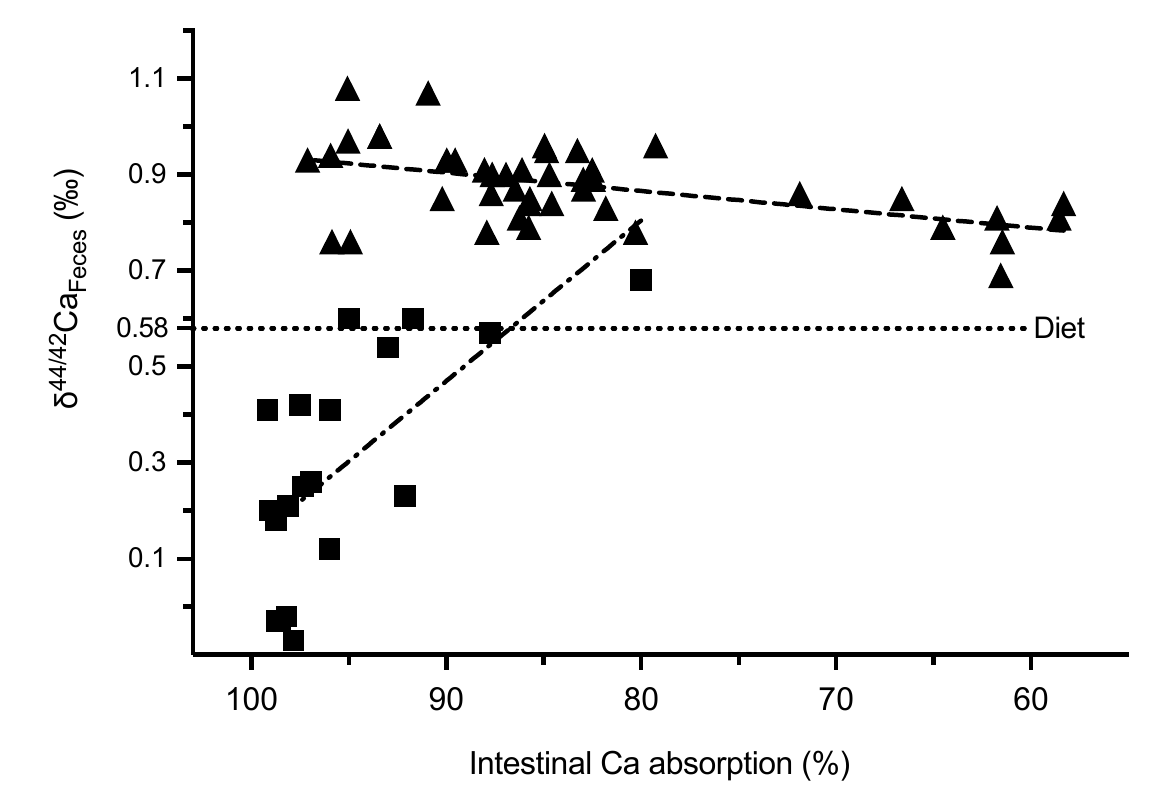
Figure 3. Relative intestinal Ca absorption versus δ 44/42 Ca Feces. The amount of Ca absorbed relative to the dietary Ca intake is given on the x-axis and δ 44/42CaFeces on the y-axis in animals on standard- Ca-diet (triangles; baseline values, group 2 weeks one to six and group 3 weeks one to two) and low-Ca-diet (squares; group 3 week three to six). The dotted line marks the isotope composition of the diet. In all animals on the standard-diet, increasing intestinal Ca absorption was accompanied by an increase in δ 44/42 Ca Feces (pearsons correlation, r = 0.50, p = 0.0006; n = 43) up to about 95% absorption. In contrast, in animals on a low-Ca-diet relative intestinal Ca absorption showed values below their corresponding δ 44/42 Ca Diet -value and correlated inversely (pearsons correlation, r = − 0.68, p = 0.0015; n = 19).